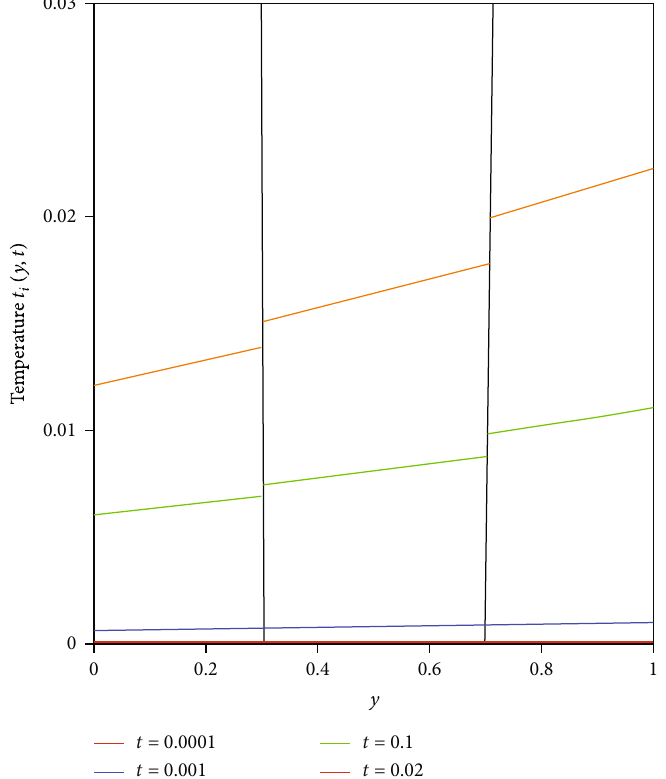
Figure 6: Temperature pro fi les T